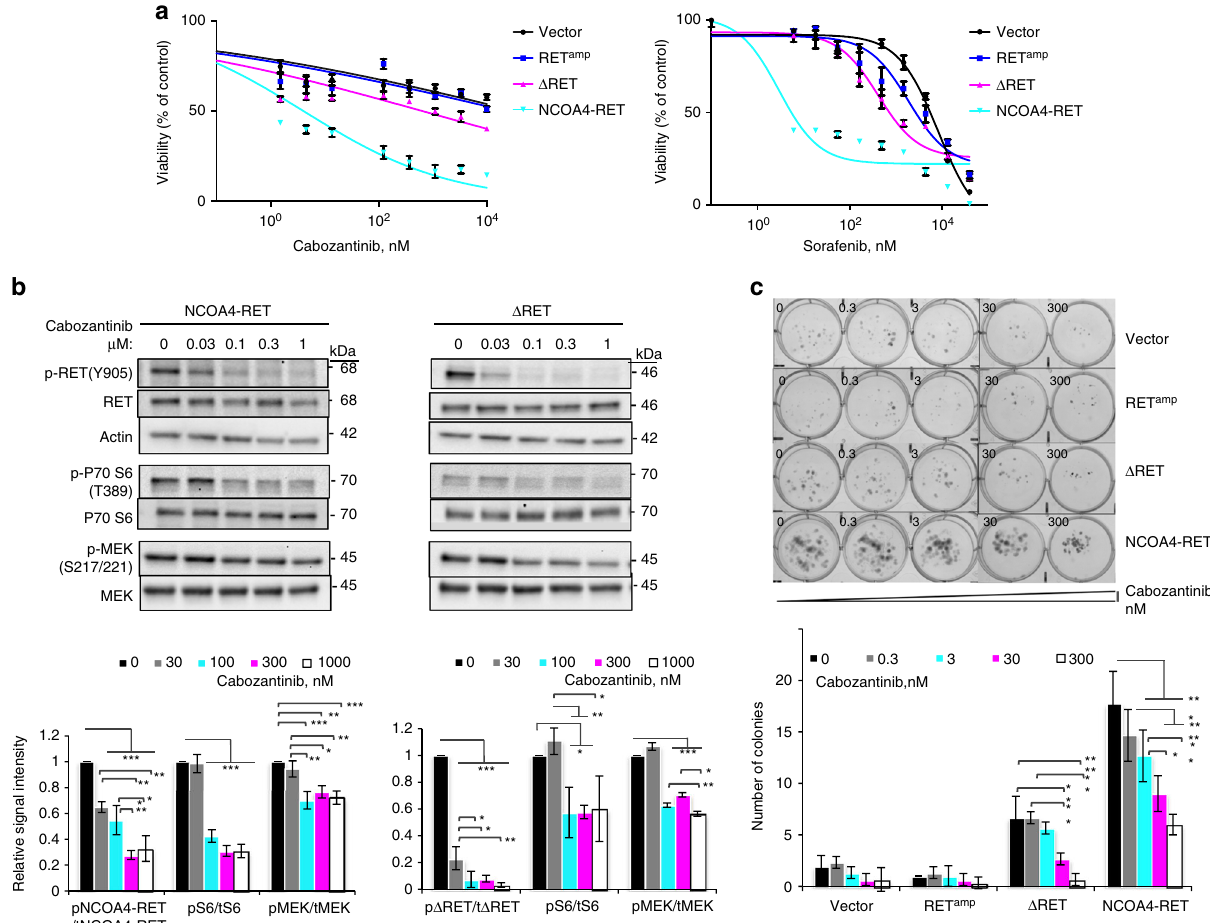
Fig. 3 Fusion cell lines exhibit dose-dependent response to RET inhibition. a Dose − response curves after 72 h of drug treatment with cabozantinib or sorafenib in NIH/3T3 cells expressing RET amp , Δ RET, NCOA4-RET, and vector. Cell viability normalized to vehicle (DMSO)-treated cells. Error bars indicate s.d. of three replicates and are representative of three independent experiments ( n = 3). b Western blot indicating inhibition of RET fusion kinase, MEK and P70 S6 signaling with increasing concentration of cabozantinib in NIH/3T3 cells transiently expressing NCOA4-RET or Δ RET. Measurements were made after overnight serum starvation and 1 h of incubation with cabozantinib in the absence of serum. Graphs represent image densitometry analysis of western blots from three independent experiments ( n = 3). Ratio of phosphorylated to total proteins is measured at each concentration and mean values with error bars indicating s.d. are plotted relative to DMSO-treated control. c Dose-dependent reduction in Δ RET and NCOA4-RET colony numbers upon treatment with increasing concentrations of cabozantinib in NIH/3T3 transduced cells for 14 days. 0 represents DMSO-treated controls. All cells were plated at equal numbers per well in triplicates per experiment. Error bars indicate s.d. of three replicate measurements per condition ( n = 3) and are representative of experiments performed three times. p ≤ 0.05 (*), ≤ 0.01 (**) and ≤ 0.001 (***) by ANOVA (one-way for ( b ) and two-way for ( c )) with Tukey ’ s multiple comparisons test. Open-ended brackets depict comparison between the indicated group and each of the groups under the bracket. Where brackets are absent, comparison is with DMSO upon tumor formation, mice were randomized into three groups Tumor protein, collected at the end of treatment on day 14 for and treated with either a low dose (30 mg kg − 1 ), high dose (60 NCOA4-RET and Δ RET, revealed signi fi cant reduction in the mg kg − 1 ) of cabozantinib, or vehicle saline. Treatment with 60 fusion protein levels and downstream PI3K-AKT signaling for the cabozantinib-treated groups as measured by western blot (Fig. 5c and Supplementary Fig. 4d). Histological analysis of the xenograft tissue for NCOA4-RET and Δ RET shows a stark contrast in tumor cellularity between vehicle and treatment groups (Fig. 5d), supporting the reduction of fusion proteins observed in Fig. 5c. A packed population of highly proliferative cells as revealed by Ki- groups in a dose-dependent manner. The treated tumors reveal zantinib in comparison to vehicle, despite increased variability hyalinization and apoptosis. Treated tumor tissues stained between mice from the same treatment group (Supplementary Fig. 4a and 4b). Overall, results indicated that all three RET alterations are sensitive to cabozantinib as evidenced by sig- ni fi cant tumor volume reduction.